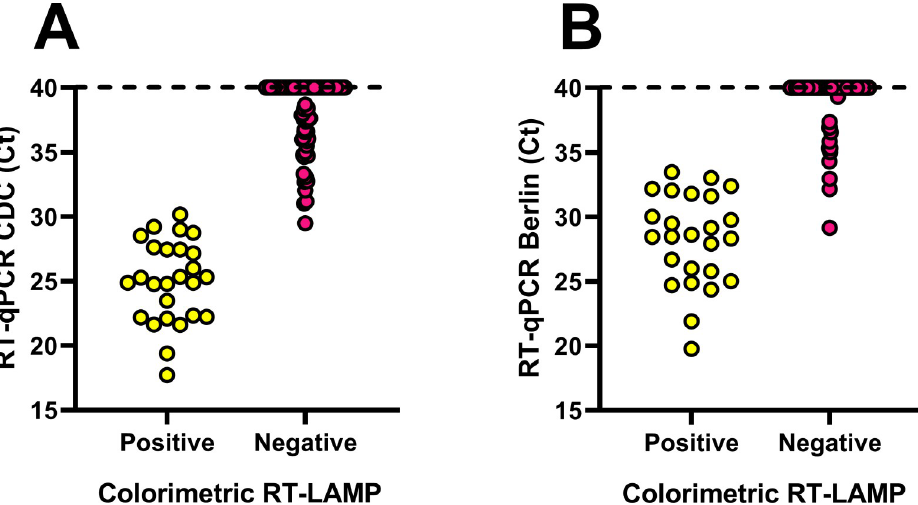
Fig 4. Evaluation of colorimetric end-point RT-LAMP assays for SARS-CoV-2 detection in clinical samples. RNA was extracted from saliva samples and evaluated for SARS-CoV-2 detection. Comparison of Ct values from RT-qPCR protocols and colorimetric end-point RT-LAMP (Colorimetric RT-LAMP) results from 100 samples tested. Negative samples (Ct > 40 and undetermined) for SARS-CoV-2 detection by RT-qPCR are shown at Ct = 40. (A) 59 samples were called positive by CDC RT-qPCR protocol-based methodology using 2019-nCoV-N1 primers/probe set (y-axis) and were compared to colorimetric RT-LAMP results (x-axis) detected as positive (yellow) or negative (pink). (B) 34 samples were called positive by Berlin RT-qPCR protocol-based methodology using RdRp_SARSr-P2 probe (y-axis) and were compared to colorimetric RT-LAMP results (x-axis) detected as positive (yellow) or negative (pink). Dashed lines at the top of each panel serve as reference for samples below the detection limit for